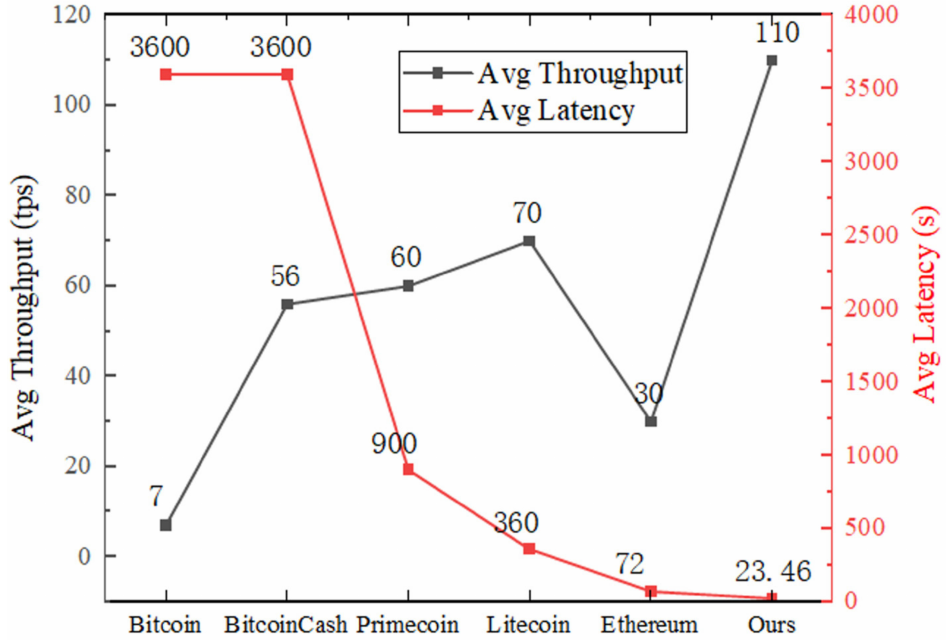
Figure 10. Comparison with current major blockchain